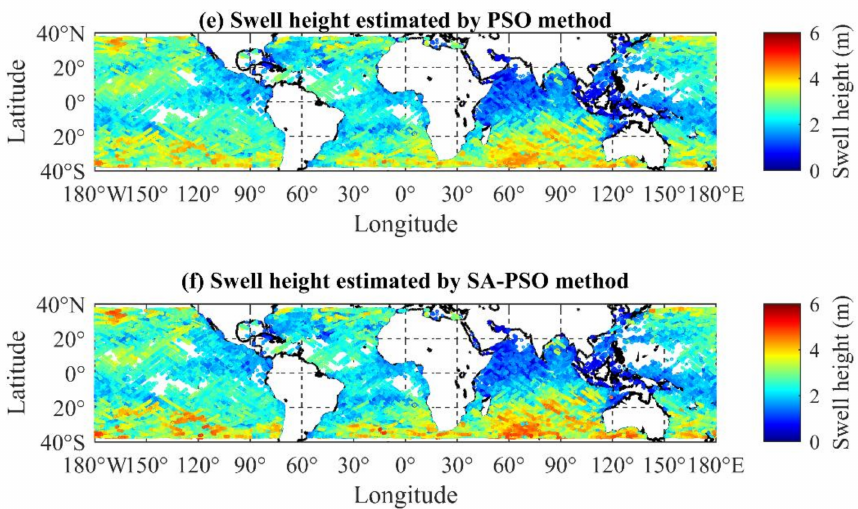
Figure 11. The distribution of the ERA5 swell height data and those calculated by GNSS-R. ( a ) ERA5,